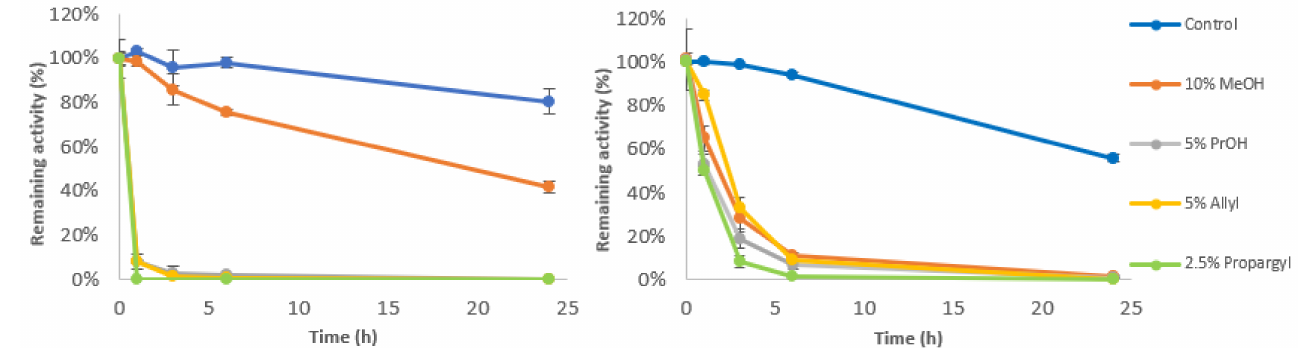
Figure 5. Stability of BoGal36A ( left ) and Aga27A ( right ) in the presence of the different acceptor molecules when incubated at 37 ◦ C over 24 h. The graphs show the remaining activity over a 24-h period correlated to a 0-h sample for each condition. Overall, Aga27A appears to be the more stable enzyme of the two in the presence of the various acceptors, with a noticeable exception for 10 v/v % methanol, where BoGal36A was the more stable